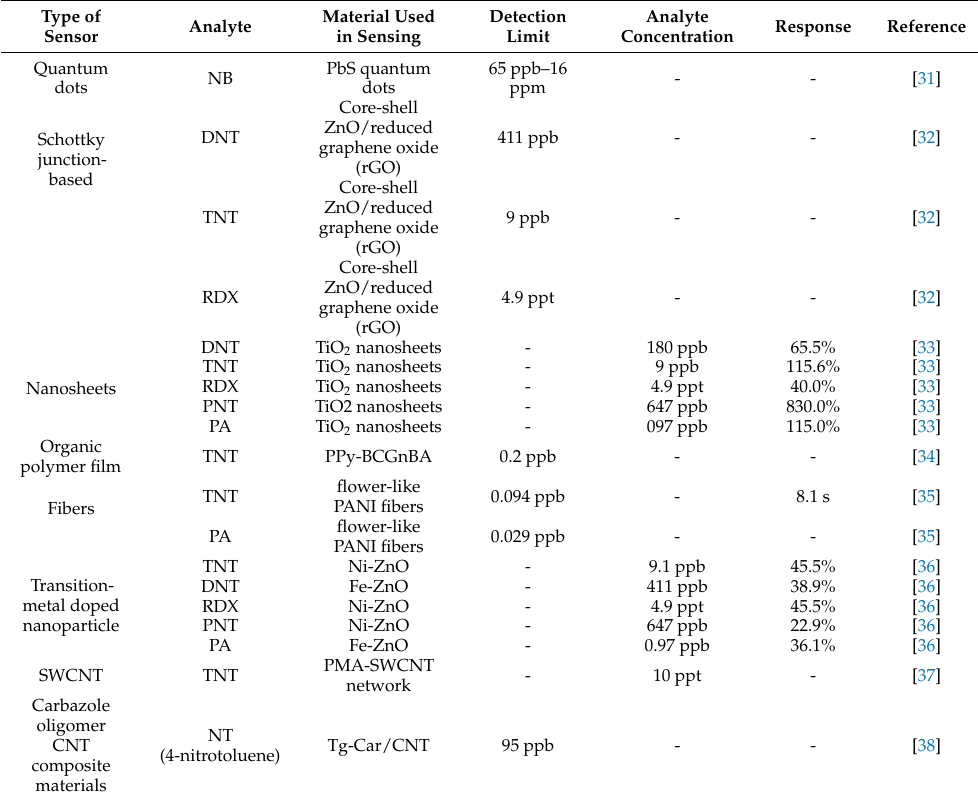
Table 1. Summary of chemiresistive sensing of nitro explosives with different